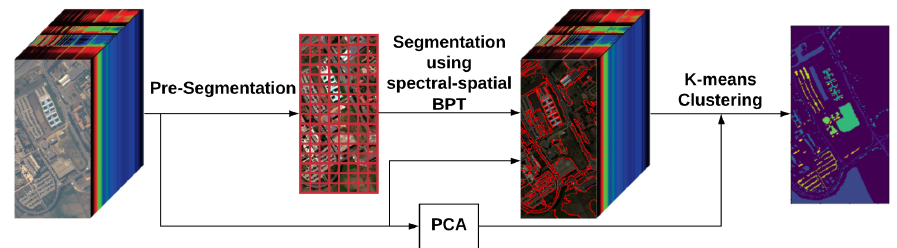
Figure 1. Flowchart of the proposed